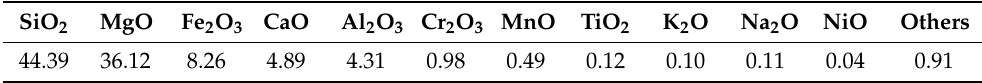
Table 1. Chemical composition of ferronickel slag